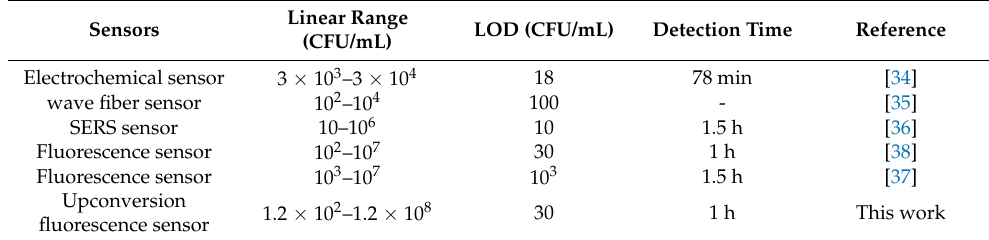
Table 1. Comparison of different sensors for Shigella